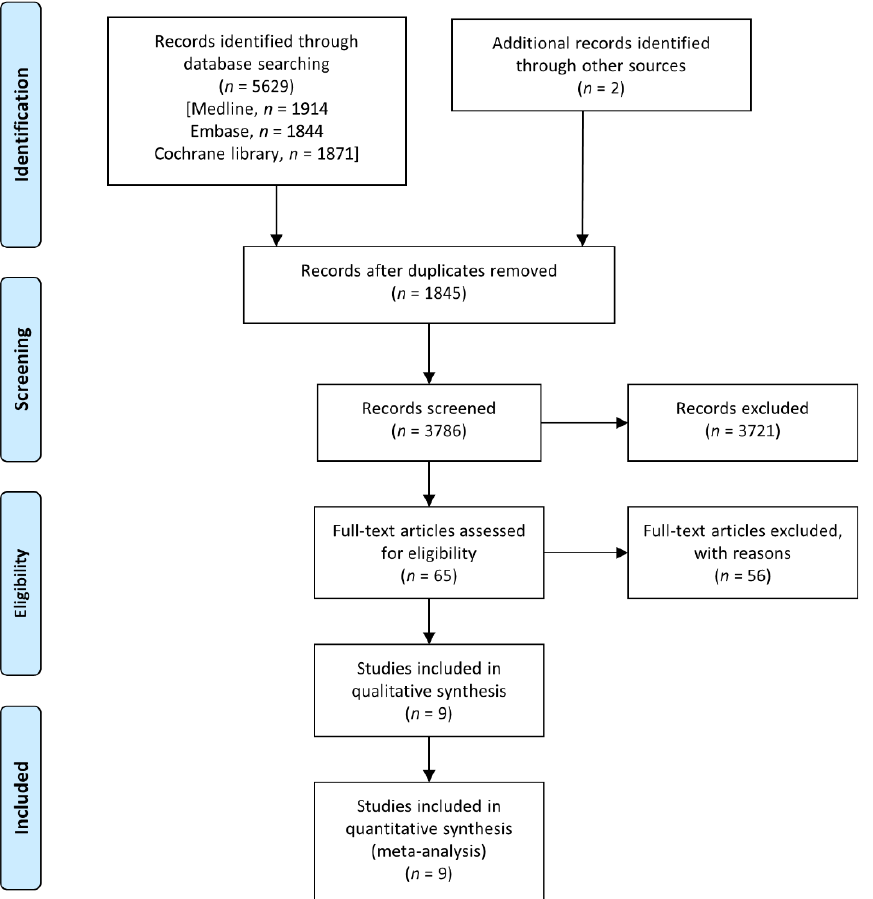
Figure 1. PRISMA flowchart of the study selection process.